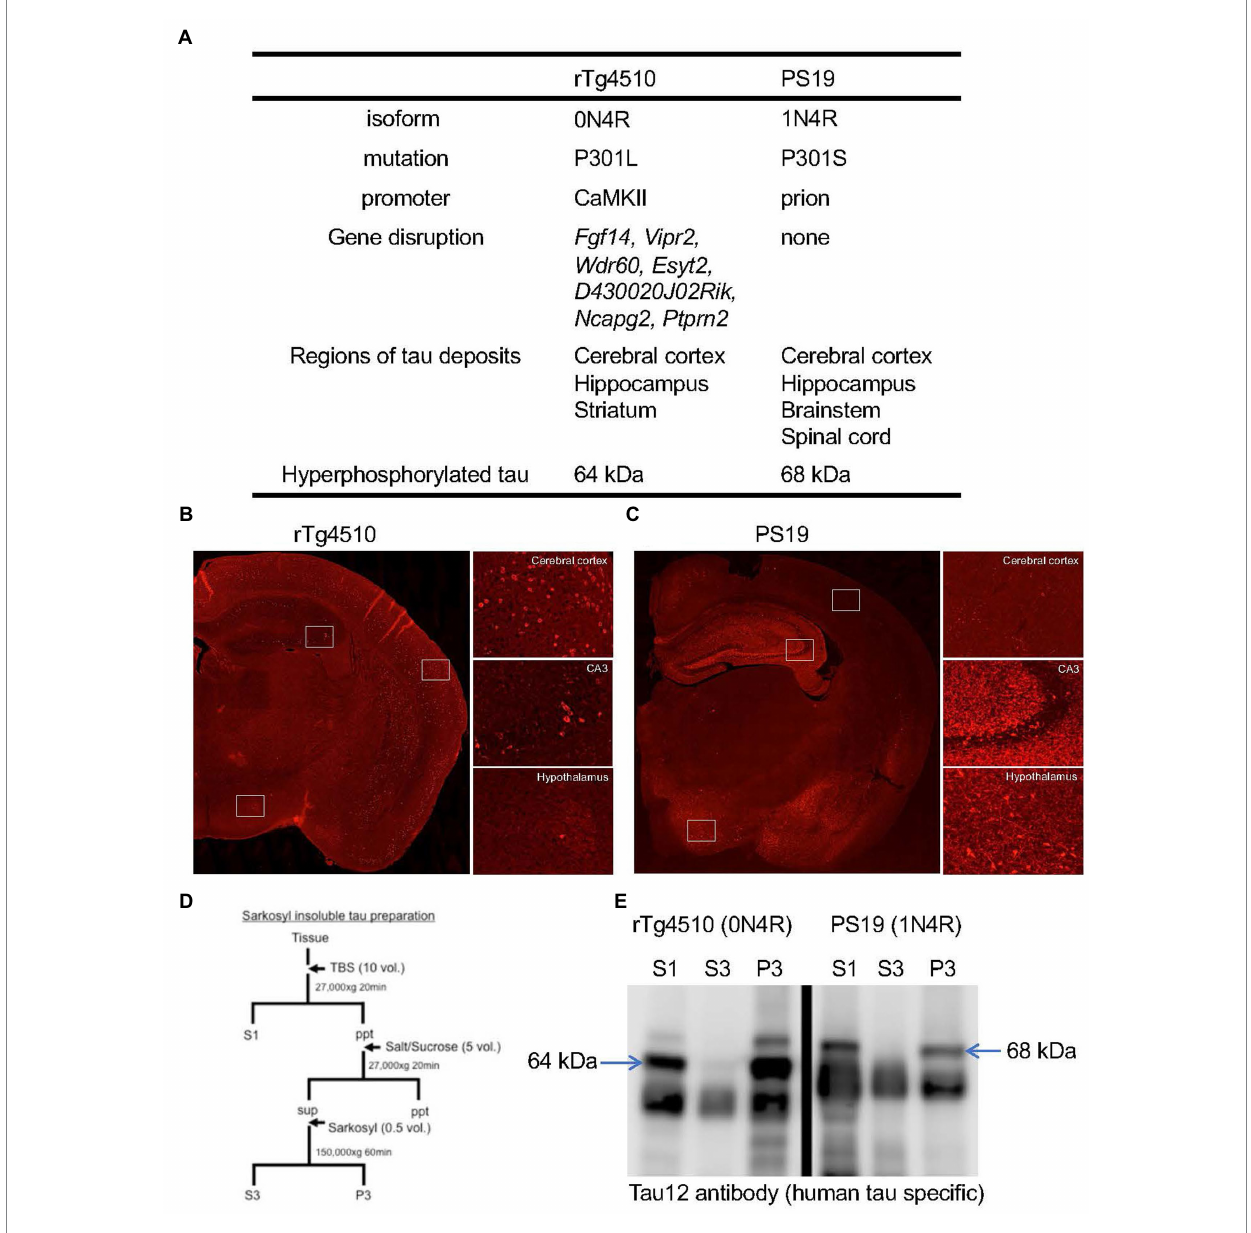
FIGURE 2 Pathological features of rTg4510 and PS19 mice. (A) Transgene constructs of tau gene, disrupted genes by transgene and distributions of tau pathology in rTg4510 and PS19 mice. (B,C) Tau immunohistochemistry on rTg4510 and PS19 mouse brain sections. Coronal sections of 7-month-old rTg4510 (B) and 12-month-old PS19 (C) mice were labeled with AT8 antibody. High-magnification views of cerebral cortex, hippocampus CA3, and hypothalamus were shown in the right panels. (D) Sample preparation protocol for the detection of tau protein from brain tissues. Tissues were separated into TBS-extractable (S1), high-salt and sarkosyl-soluble (S3) and sarkosyl-insoluble (P3) fractions. (E) Western blot of brain samples from 13-month-old rTg4510 and 10-month-old PS19 mice probed with human tau specific antibody, Tau12. Arrows indicate 64 kDa and 68 kDa hyperphosphorylated